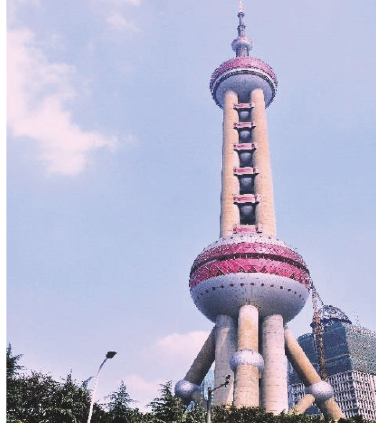
Figure 2: Oriental pearl radio and TV tower,